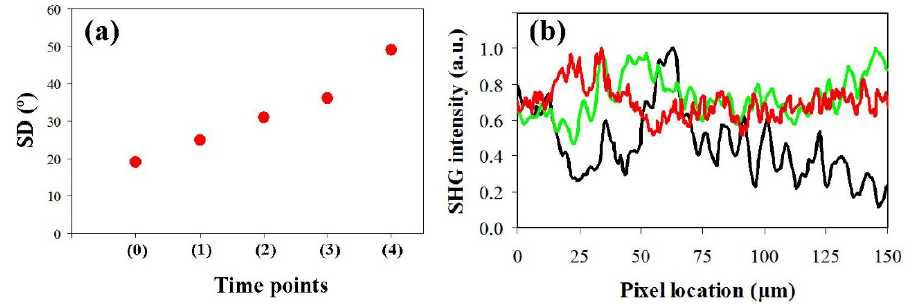
Figure 5. ( a ) Human edema temporal progression in terms of SD. ( b ) Intensity profiles for SHG images in Figure 4, along the indicated dotted line. Black line: control (Figure 4a); green and red lines: two different temporal stages (Figure 4c,e, respectively).